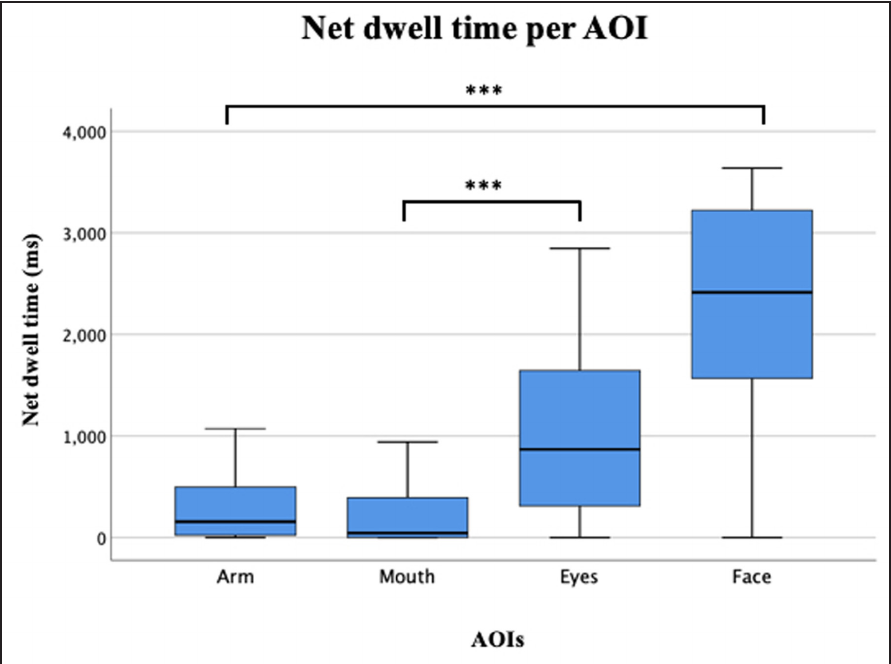
Figure 2: Boxplots displaying net dwell time per